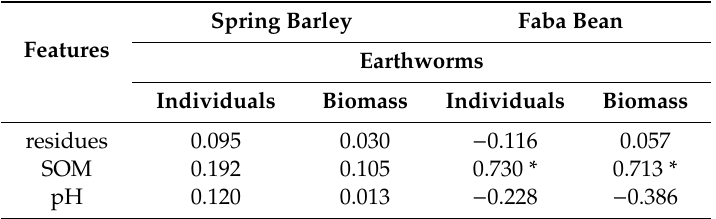
Table 6. The correlation coe ffi cient (r) between density and biomass of earthworms with SOM, pH, and post-harvest residues of spring barley and faba bean